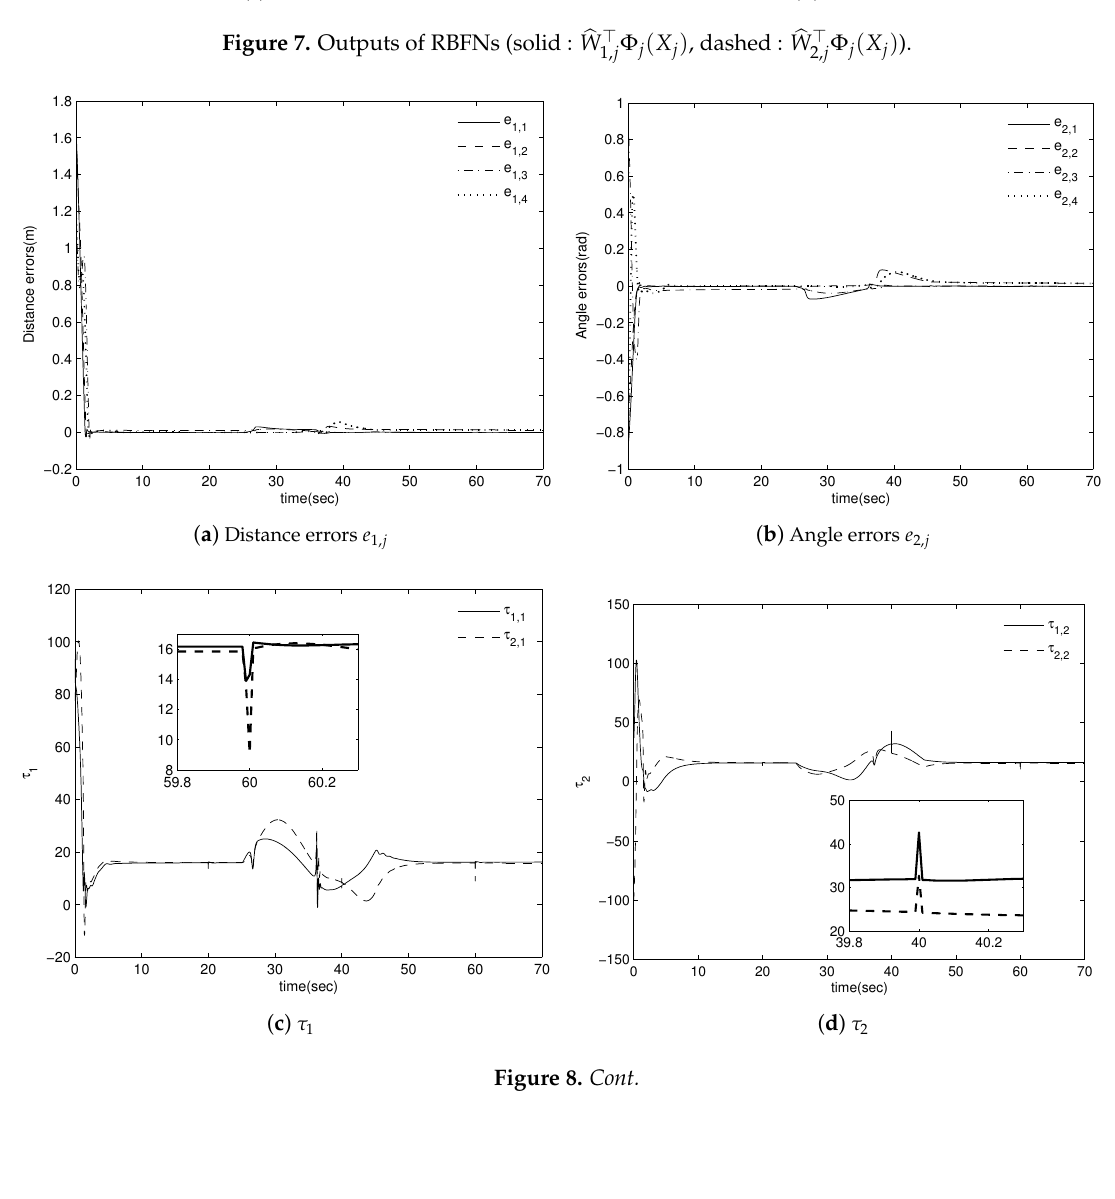
Figure 7. Outputs of RBFNs (solid : (cid:98) W (cid:62)